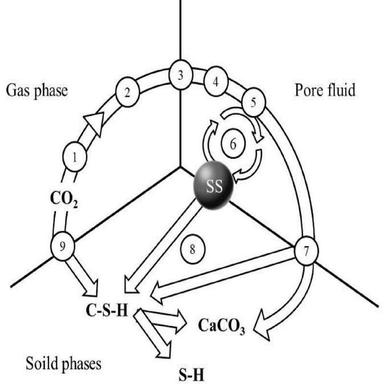
The mechanism for carbonation curing of SS. Redrawn from Ref..